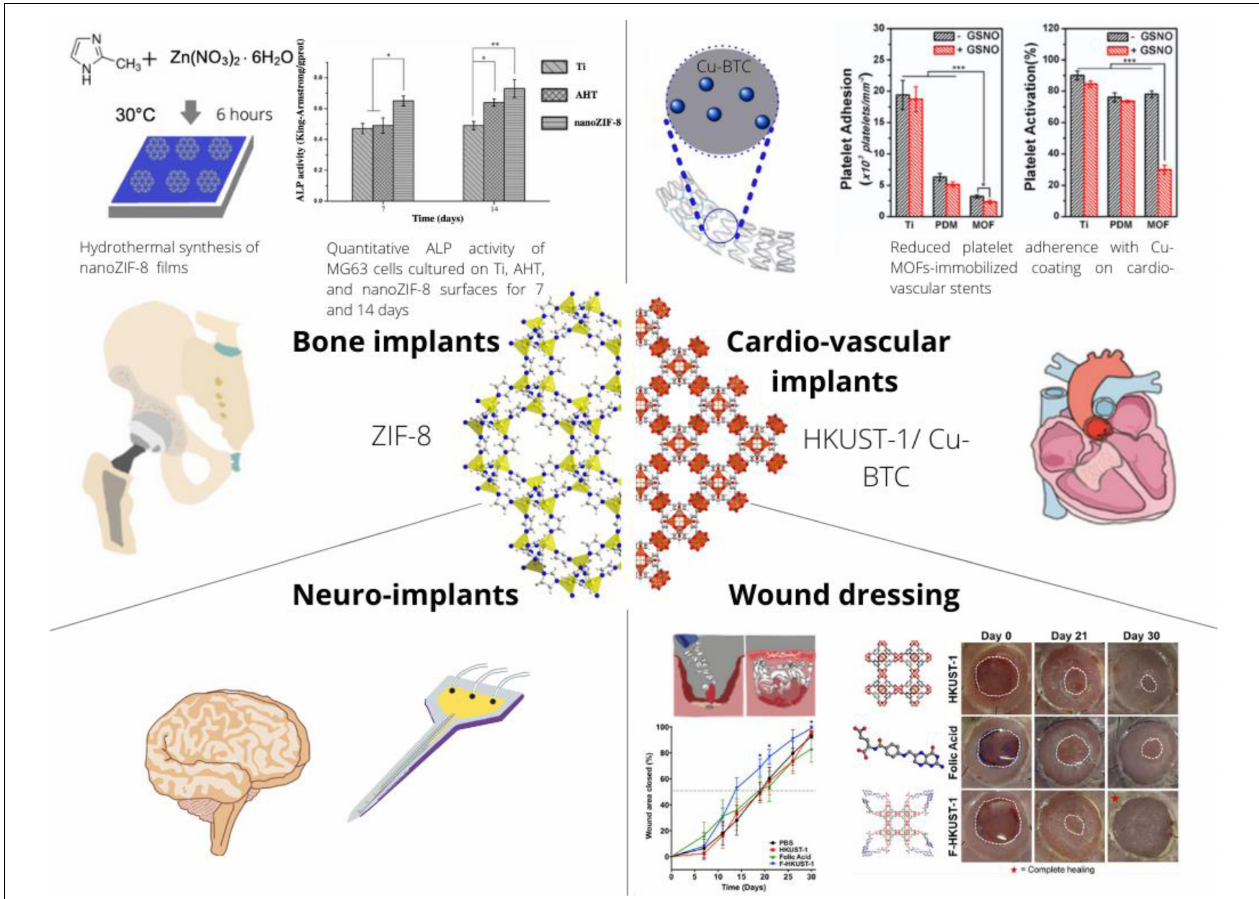
FIGURE 1 | Schematic on the present and envisioned use of MOFs as a component of implants or biomaterial compositions with applications in Tissue Engineering and Regenerative Medicine (TERM). The crystal structure of the prototypical MOF Zeolitic Imidazolate Framework 8 (ZIF-8) is depicted along the [111] crystallographic direction (left side) and HKUST-1 also known as Cu-BTC is depicted along the [001] crystallographic direction. These two different structures have been most frequently applied to TERM research and represent the diverse class of MOFs. In particular, simple exposure of osteoblast like cells to ZIF-8 increases ALP activity (Chen et al., 2017a), Cu-BTC can decrease adherence and activation of platelets (Fan et al., 2019) and also accelerates skin wound closure (Xiao et al.,